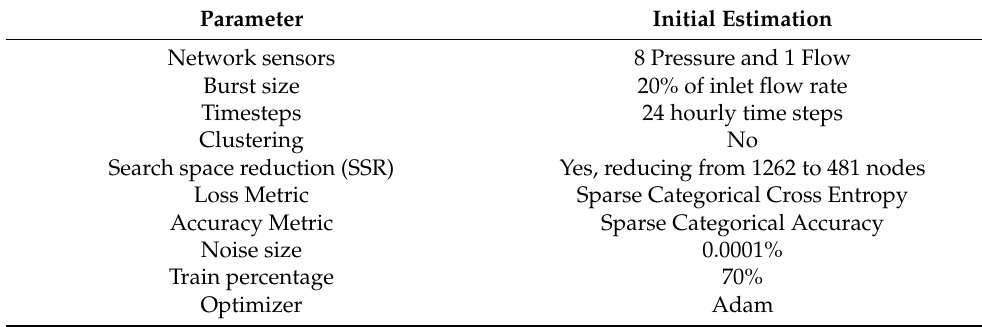
Table 1. Initial set of estimated